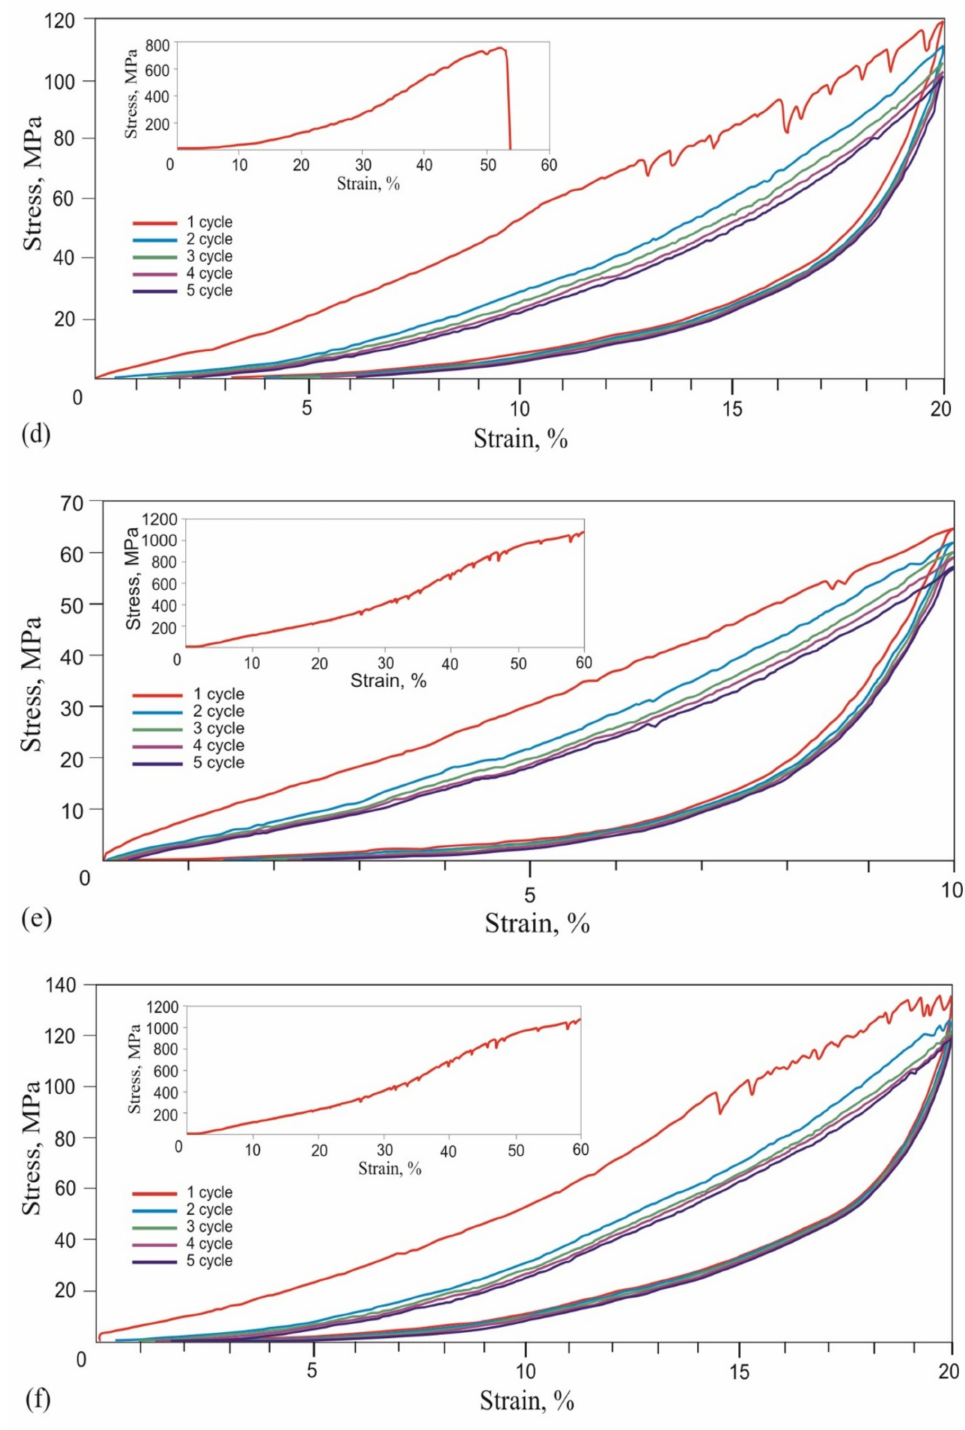
Figure 13. Engineering stress-strain curves of ( a , b ) 40 µ m, ( c , d ) 60 µ m, and ( e , f ) 90 µ m knitted NiTi mesh under 5 loading-unloading cycles; uniaxial tension to fracture